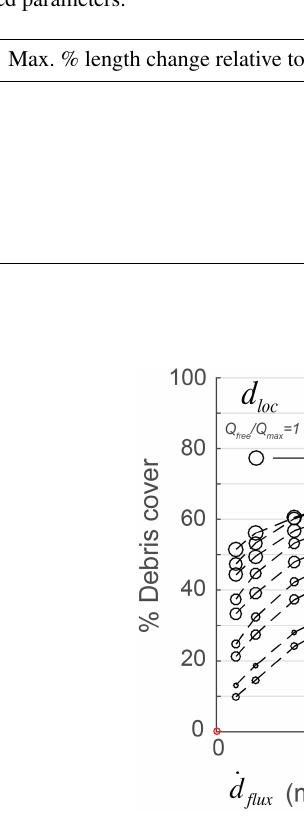
Figure 8. Debris-related results from 36 simulations varying d loc and ˙ d flux . All black circles are derived from steady state debris- covered glaciers. Red circle shows results from the debris-free glacier. Dashed lines connect simulations with the same d loc